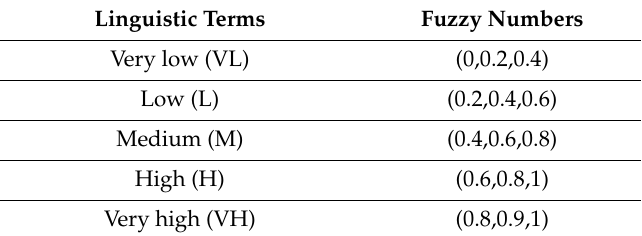
Table 4. Linguistic variables and fuzzy ratings of the criteria.